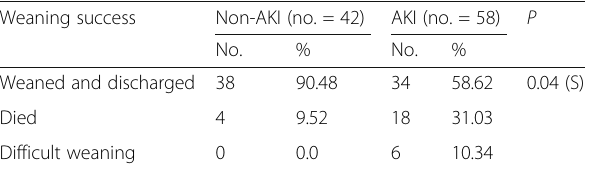
Table 4 Comparison of weaning success between AKI and non- AKI cases Weaning success